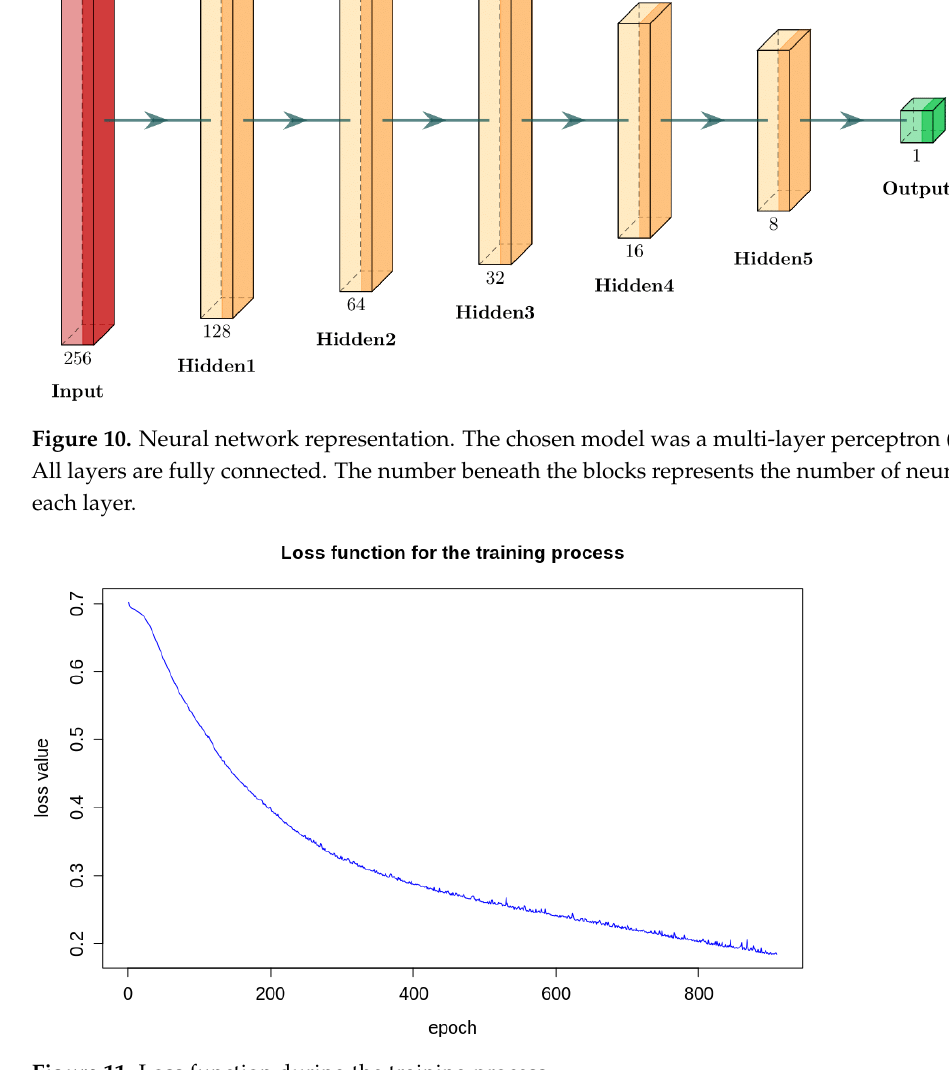
Figure 11. Loss function during the training